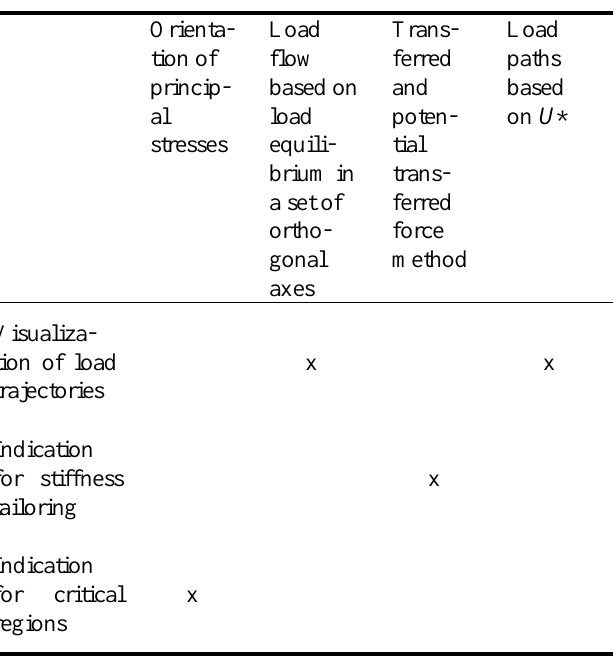
Table 1. Summary of comparison of various load path definitions against the pre-defined criteria